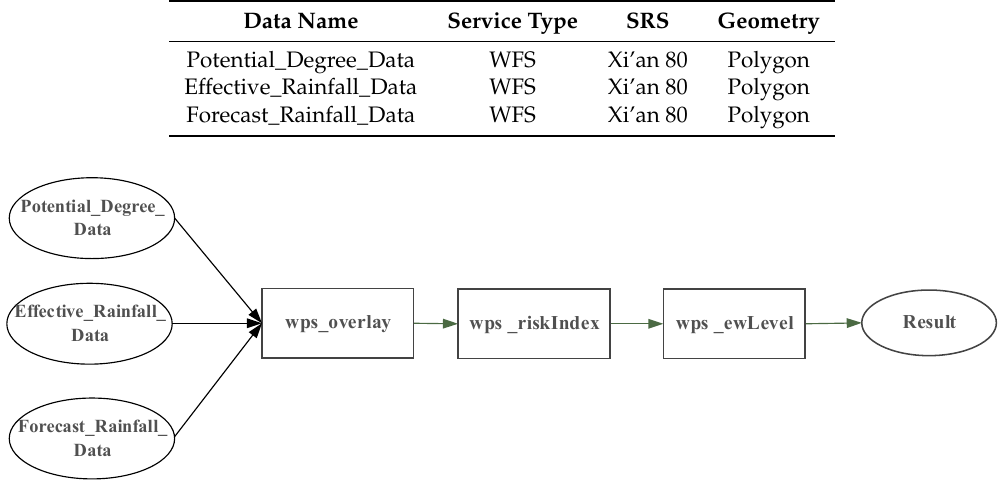
Figure 12. The workflow model of EWATask. Data access services are represented in elliptical shapes, and geoprocessing services are represented in rectangular shapes.